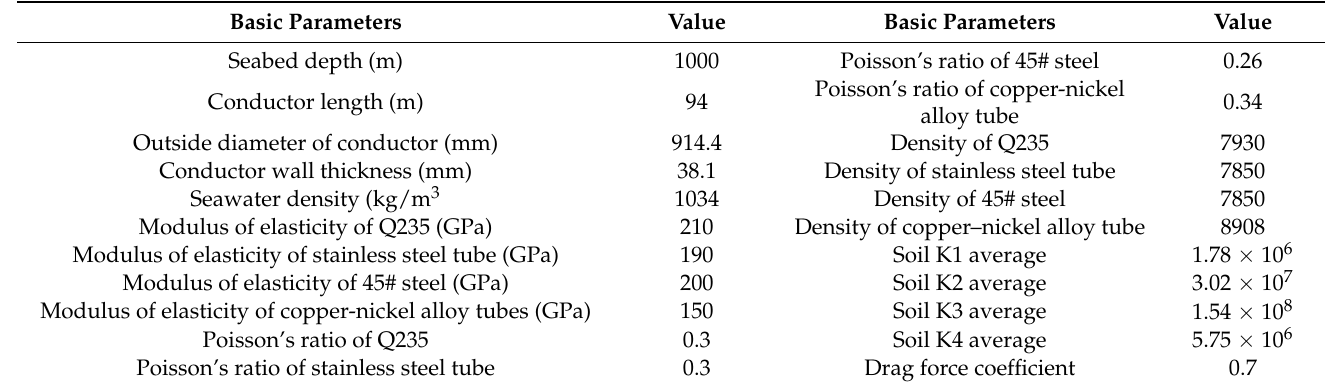
Table 2. Basic parameters.